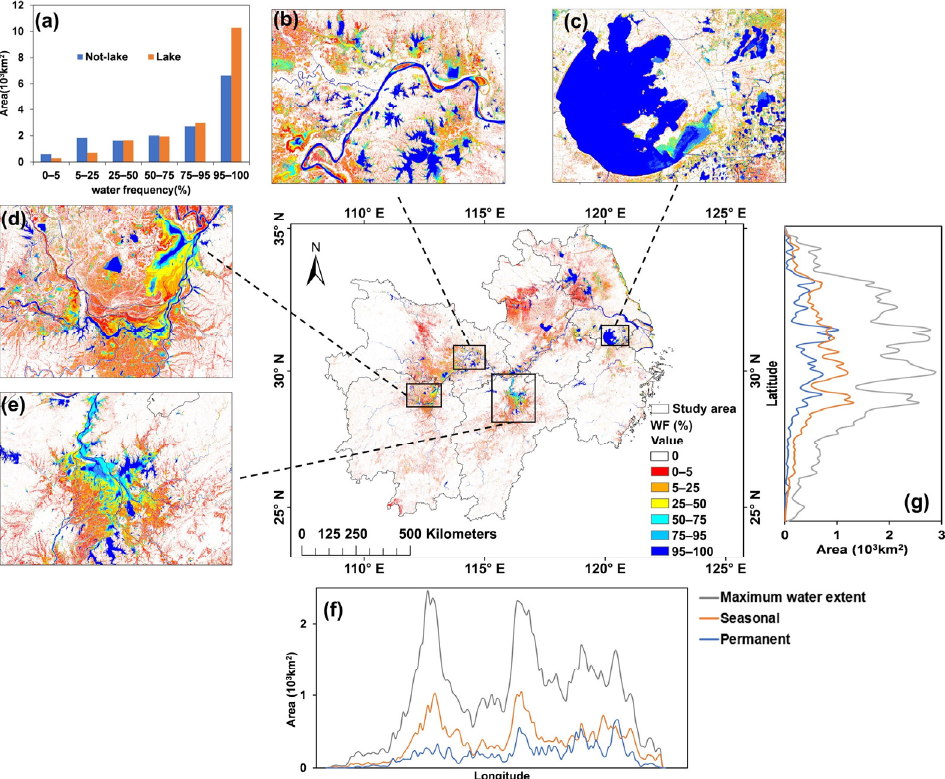
Figure 7. Maps of the overall and locally ampli fi ed spatial distributions of open-surface water frequencies in the MLYP from 1984 to 2020. ( a ) Comparison of lake and non-lake water frequencies. ( b ) Wuhan Lakes Group, ( c ) Taihu Lake, ( d ) Dongting Lake and ( e ) Poyang Lake ( f ) with 0.1° longitude summaries of the open-surface water area and ( g ) with 0.1° latitude summaries of the open-surface water area.